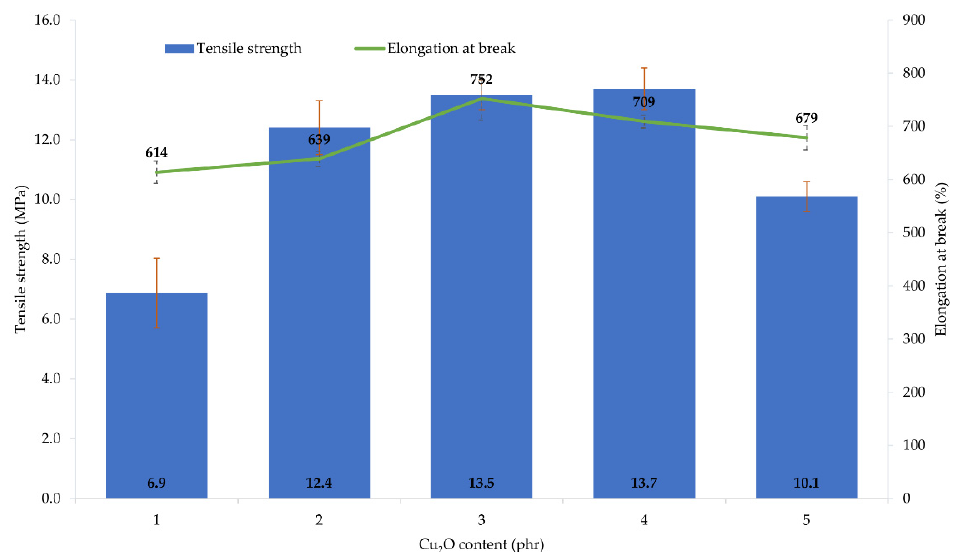
Figure 3. Mechanical properties of the CR compositions containing copper(I) oxide (1–5 phr of Cu 2 O); T = 160 °C, t = 45 min.